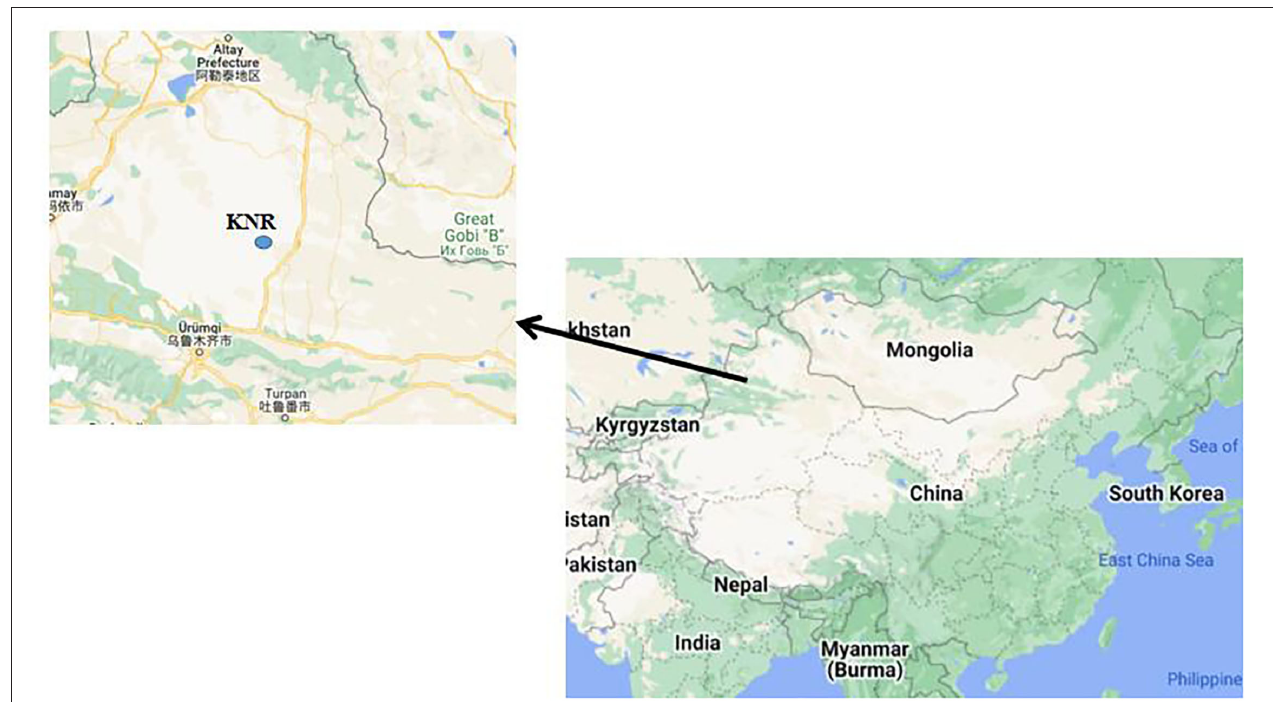
FIGURE 1 | Location of KNR. The figure was generated by Google Maps. Arrow represents the location of